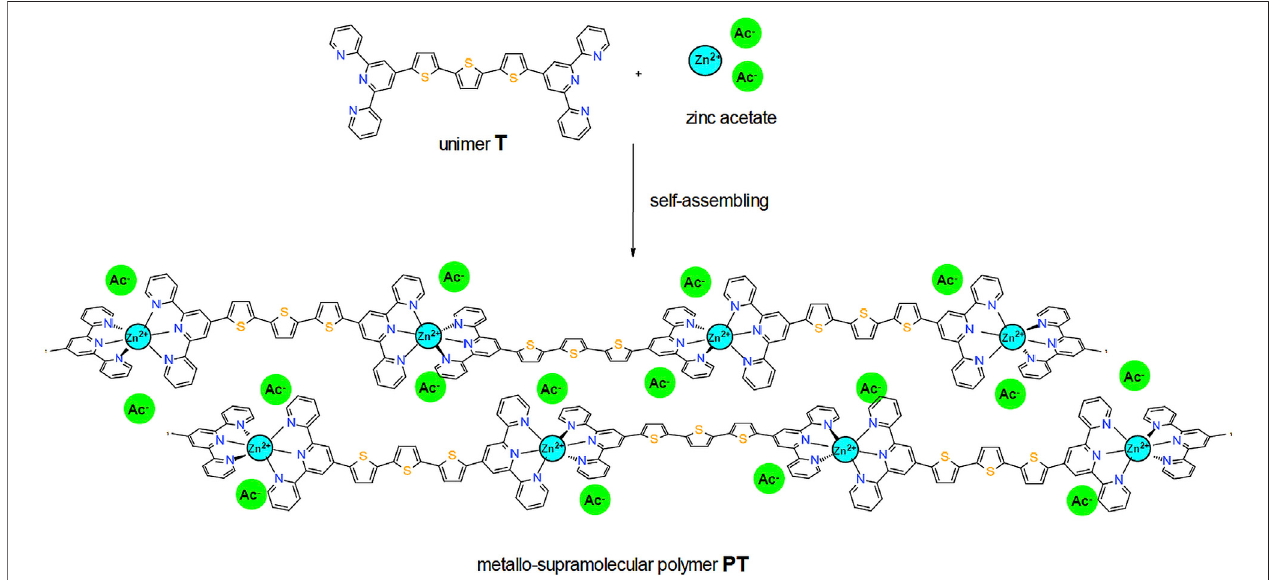
FIGURE 1 | Formation of supramolecular structure of thin fi lms of the metallo-supramolecular polymer PT.